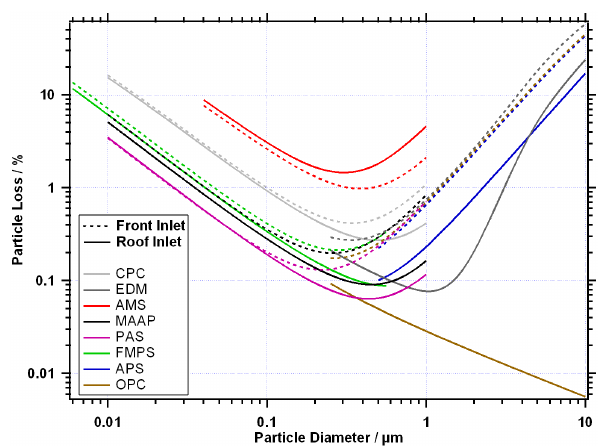
Fig. 4. Overview of inlet transport losses as a function of particle diameter for all aerosol instruments in MoLa. The solid lines rep- resent the loss calculations for the roof inlet and for 6m sampling height; the dashed lines represent the calculations for the upper front